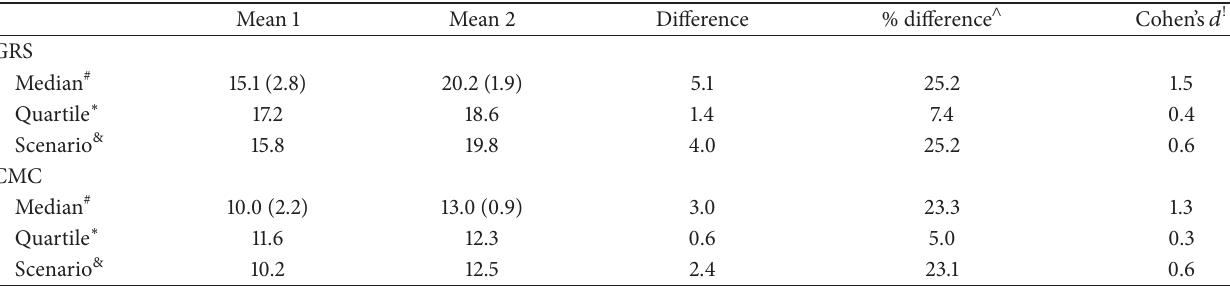
Table 5: Estimation of effect sizes.